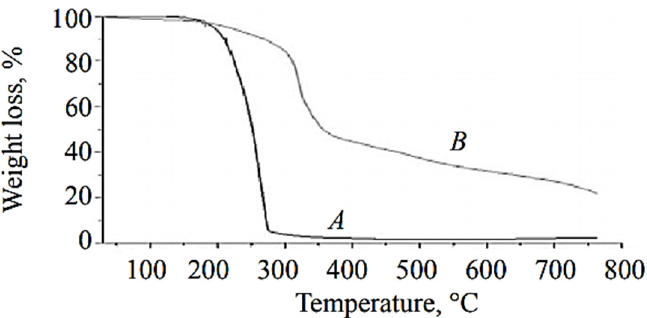
Figure 14. Comparative TGA curves for ( A ) pure metribuzin as a core and ( B ) polyurea microcapsules. From reference [49].